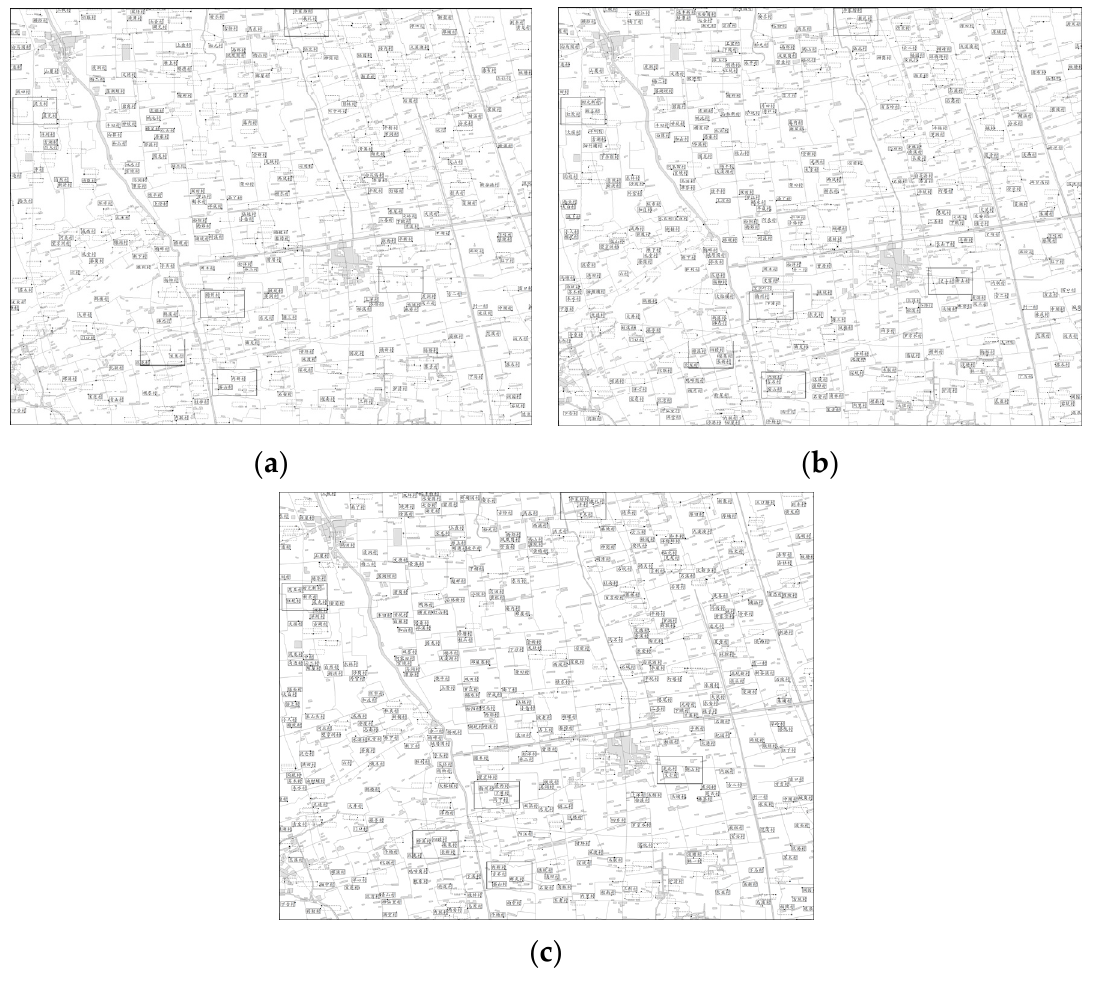
Figure 13. Labeling result for the RoadResident instance with 558 points. And the Chinese words are the geographic names to be labeled with no conflict. ( a ) Four-position model: 209 conflict-free labels; ( b ) four-slider model: 290 conflict-free labels; ( c ) the proposed model: 351 conflict-free